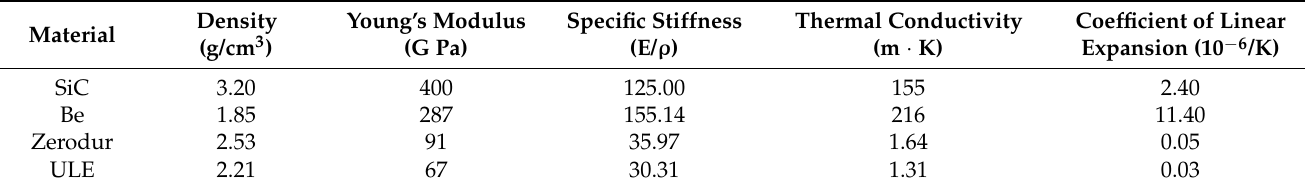
Table 2. Properties of common